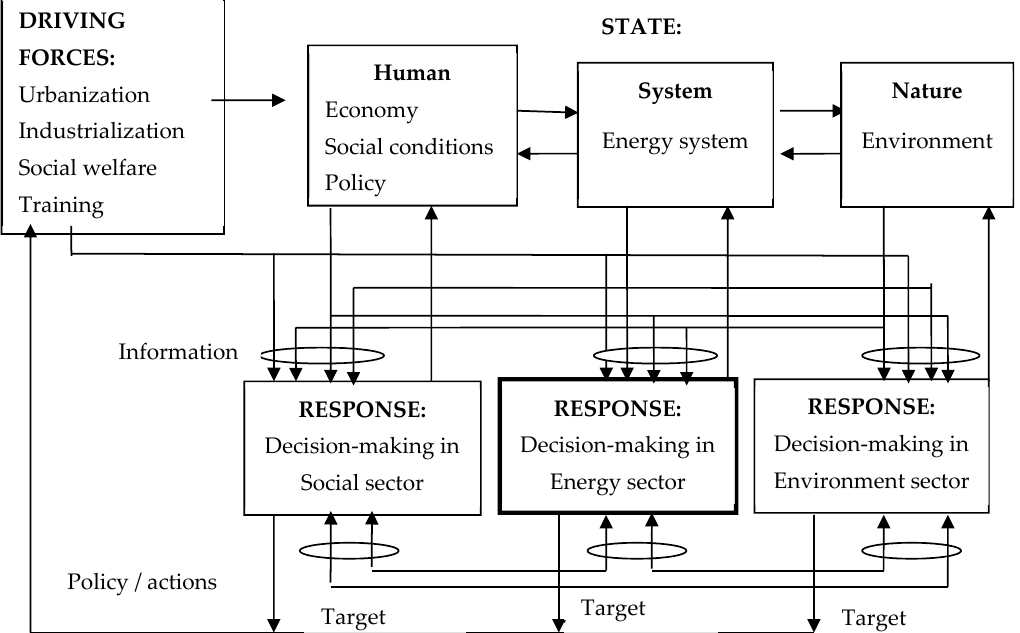
Figure 1. The interrelations between sustainability dimensions and decision-making in the energy sector (prepared according to Meyar-Naimi, Vaez-Zadeh [2]).